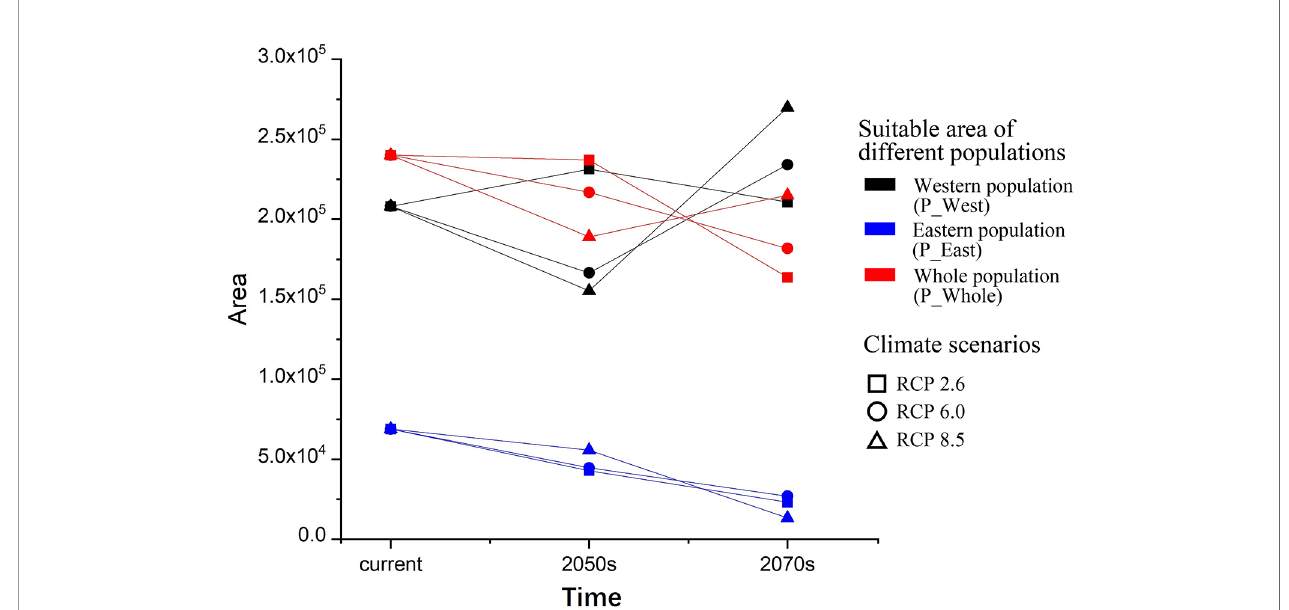
FIGURE 6 | Suitable areas and their changes under climate change. Both areas (P_East and P_Whole) may decrease under climate change in the 2070s under three RCPs, while P_West may increase slightly in the 2070s under three RCPs although it may face a decrease in the 2050s under RCP6.0 and